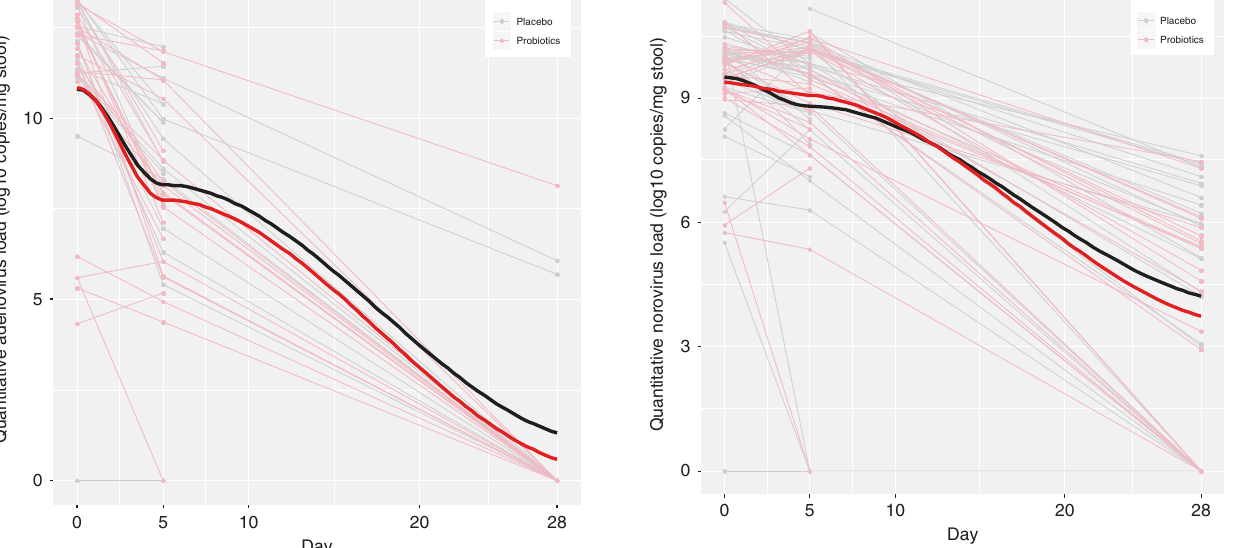
twice-daily administration of a combined L. rhamnosus/L. hel-